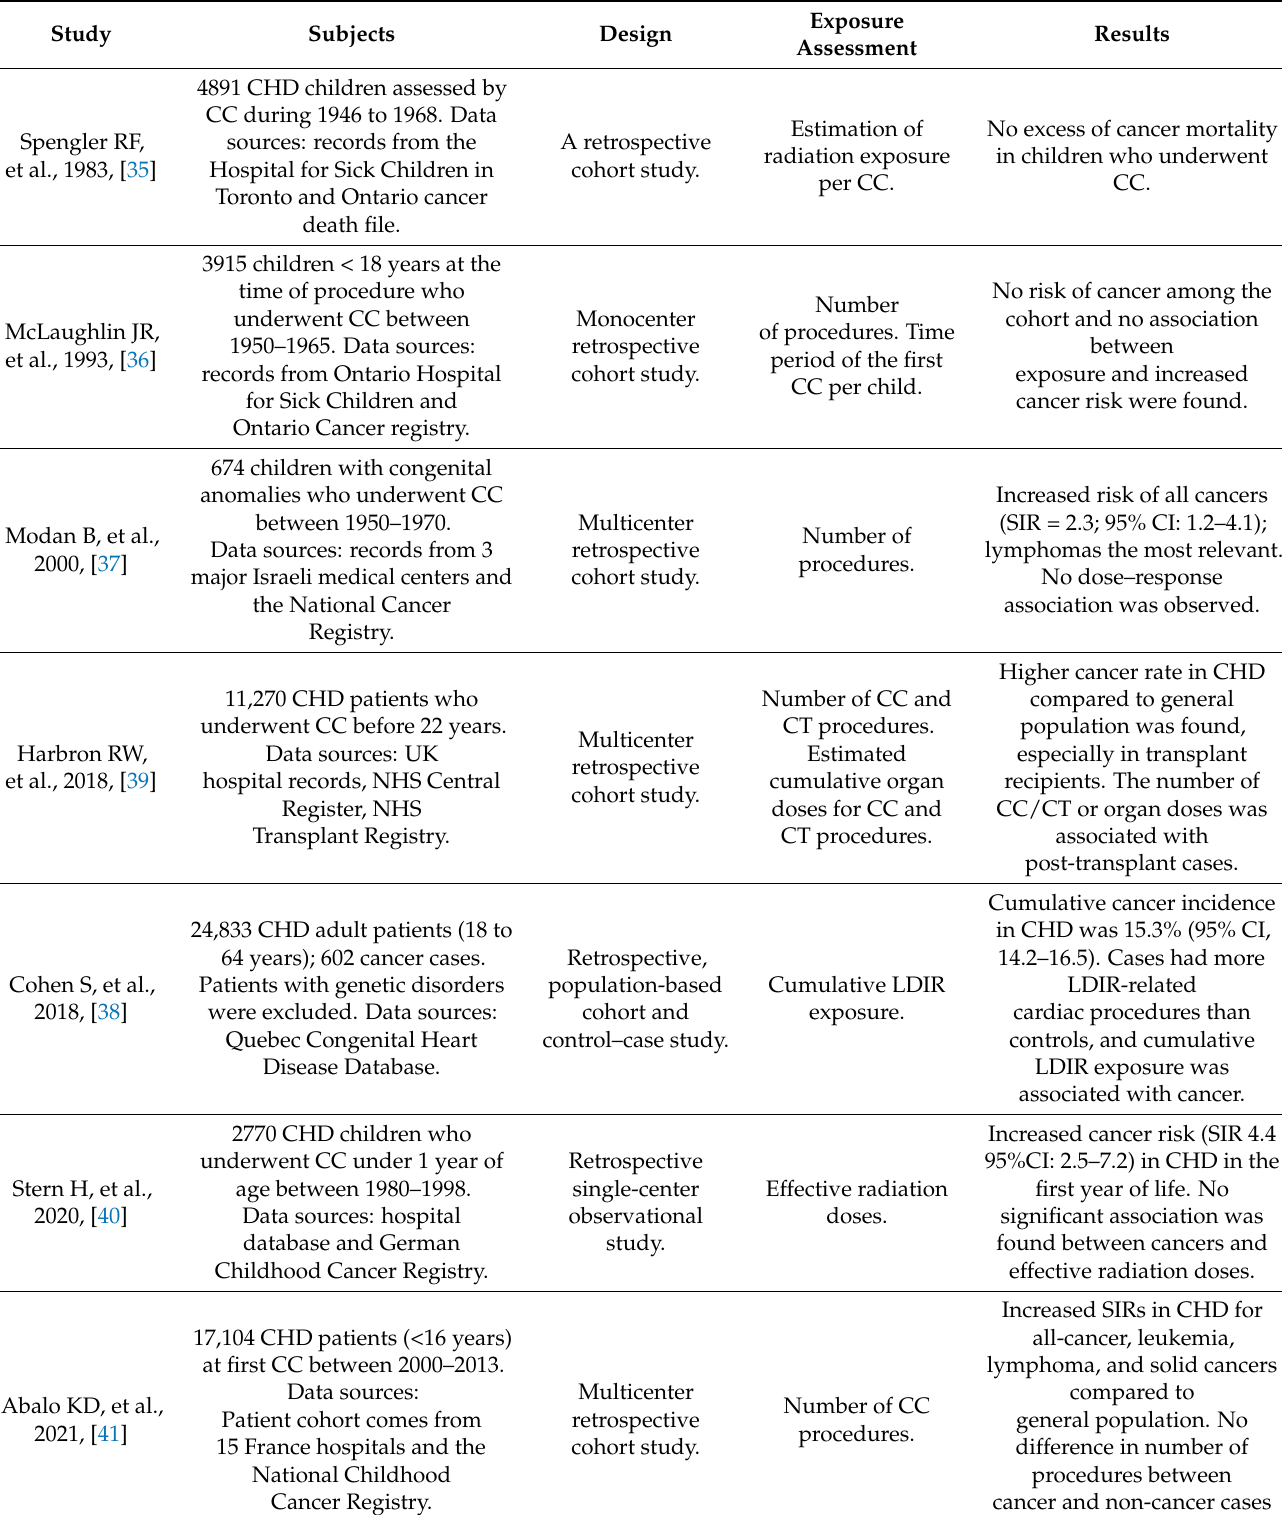
Table 3. Previous studies on the association among CHD, cancer, and radiation